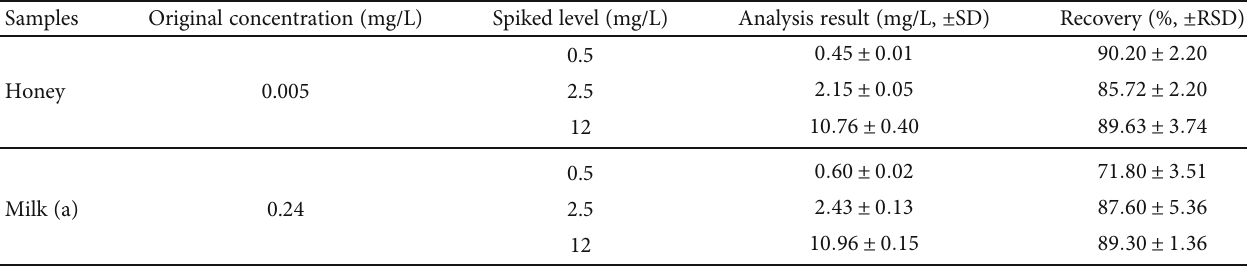
Table 2: The recoveries of spiked sulfadiazine in honey and milk (a) samples determined using the BELISA method. Samples Original concentration (mg/L)